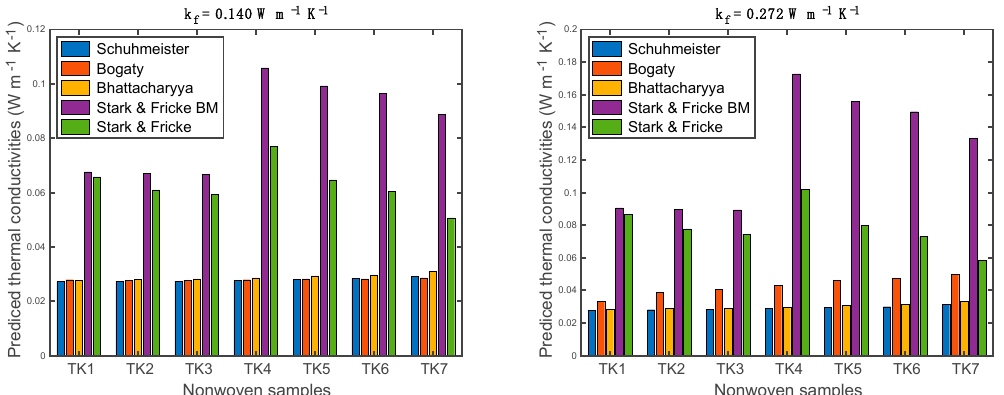
Figure 9. Predicted thermal conductivities of nonwoven samples based on different models.